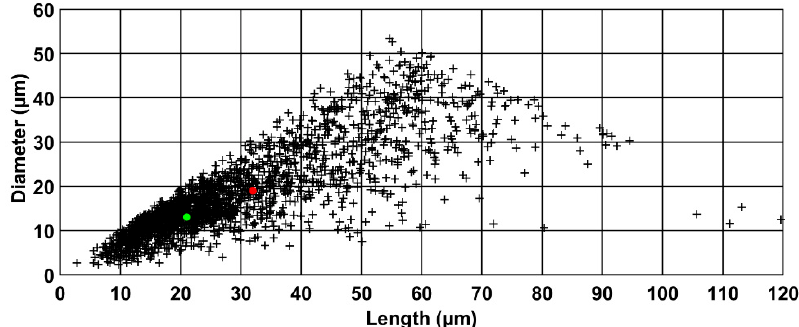
Figure 2. Scatter plot of the length according to the diameter of cellulose particles (red point = median value in volume, green point = mean value in volume).